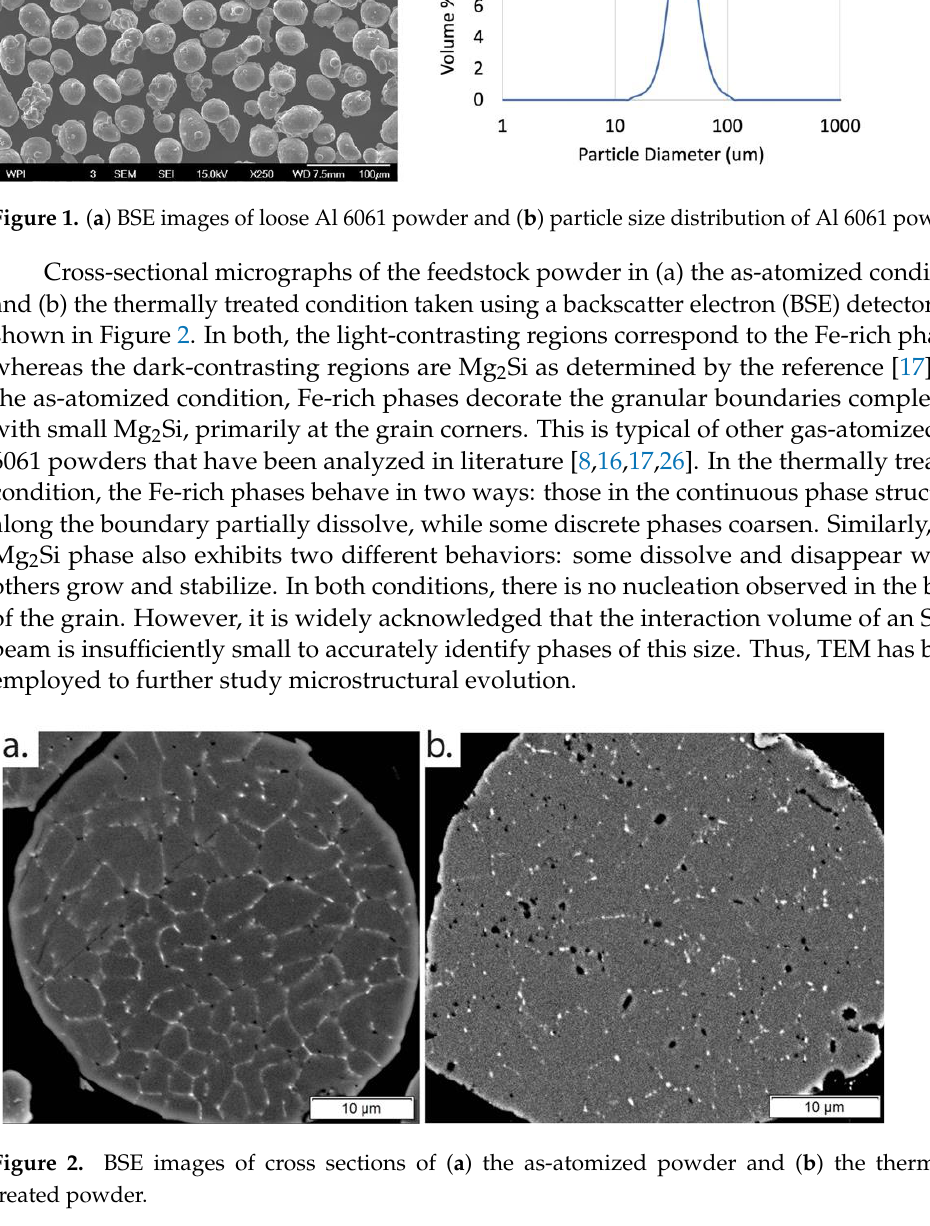
Figure 1. ( a ) BSE images of loose Al 6061 powder and ( b ) particle size distribution of Al 6061 powder.